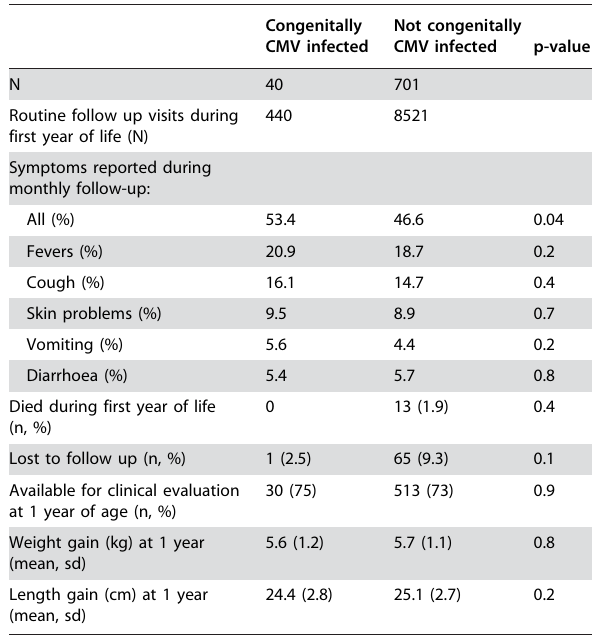
Table 4. Clinical characteristics of children with and without congenital CMV infection who already reached one year of